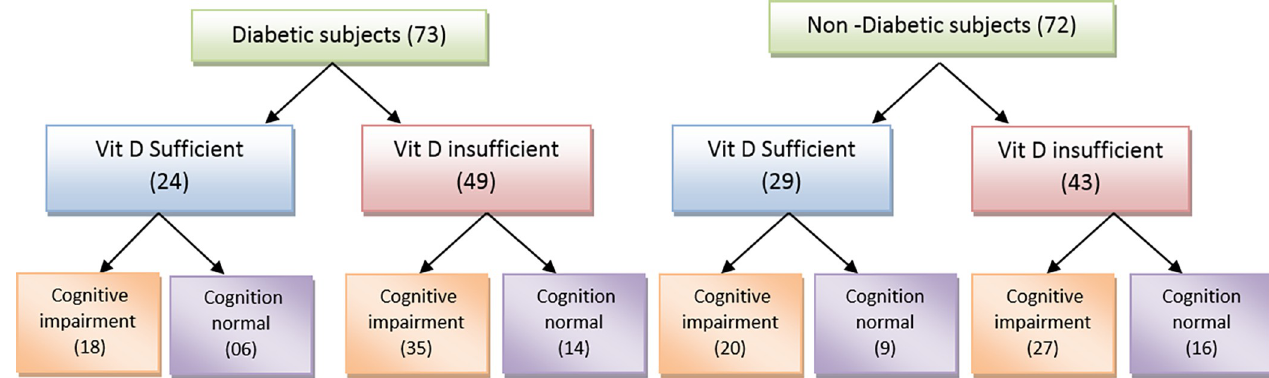
Fig 1. Schematic flow chart for recruitment and classification of study subjects based on the diabetes condition, vitamin-D levels and cognition status (3MSE).